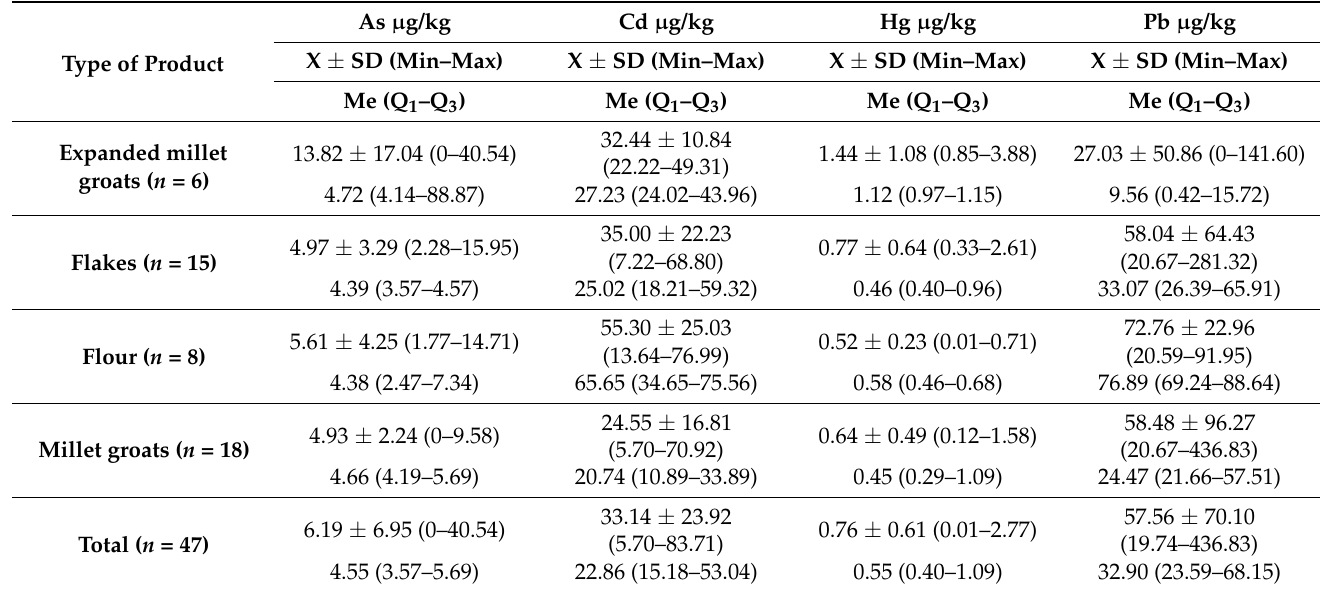
Table 3. The content of the toxic elements in millet products.